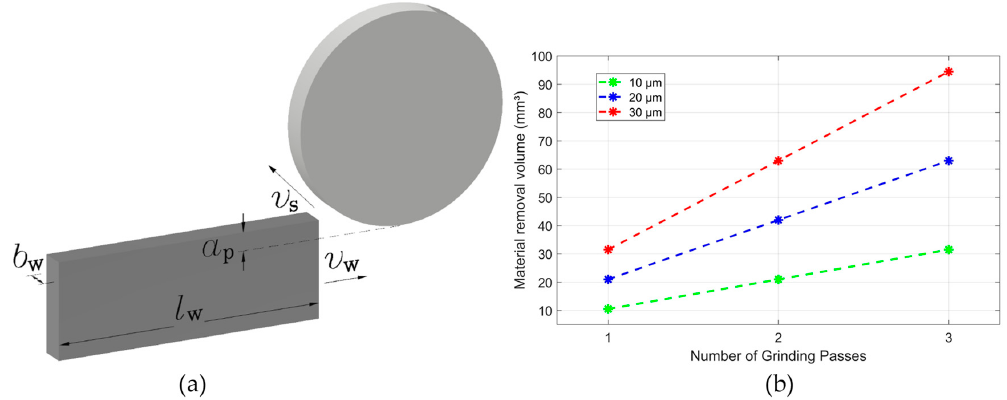
Figure 5. ( a ) Schematic for grinding process with cutting parameters; ( b ) material removal volume as a function of the grinding pass.